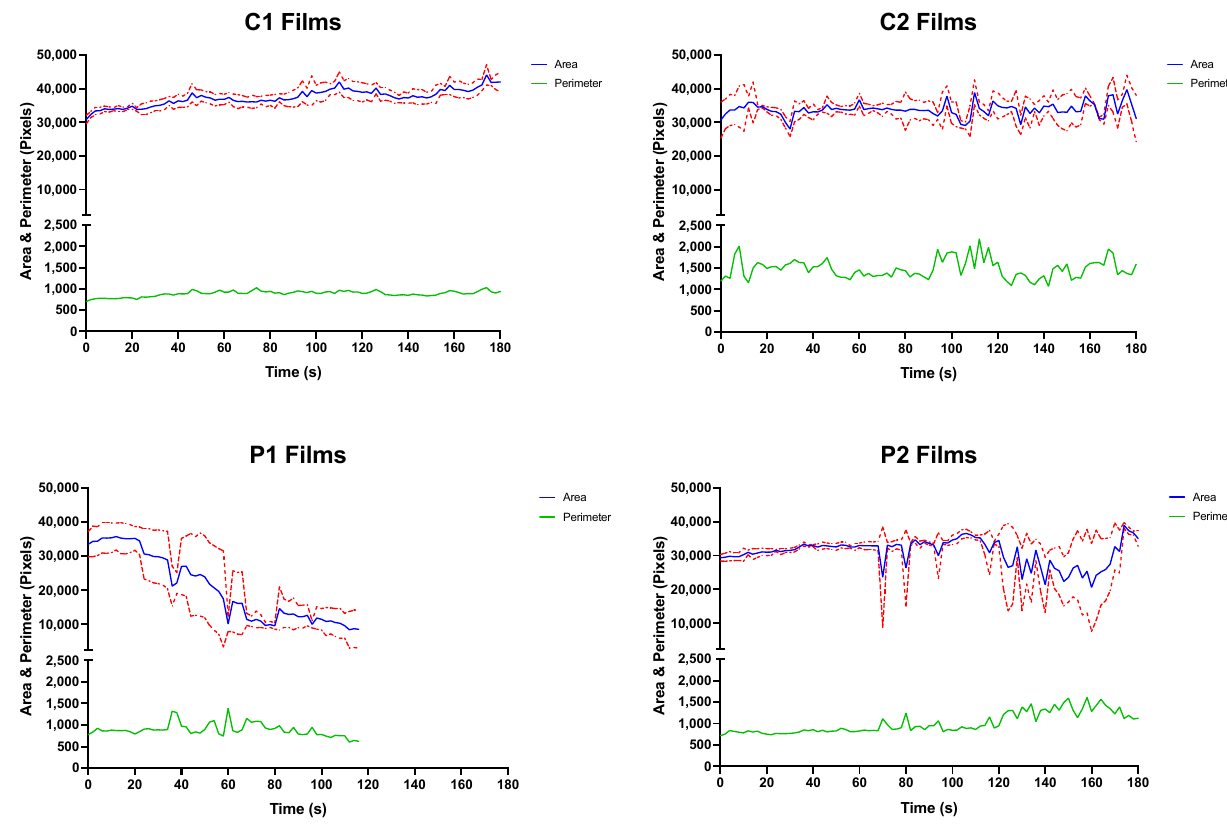
Figure 3. Mean top-down area-time and perimeter–time profiles for C1 ( top left ), C2 ( top right ), P1 ( bottom left ) and P2 ( top right ) ODFs assessed in the OCM with standard deviations ( n = 3).